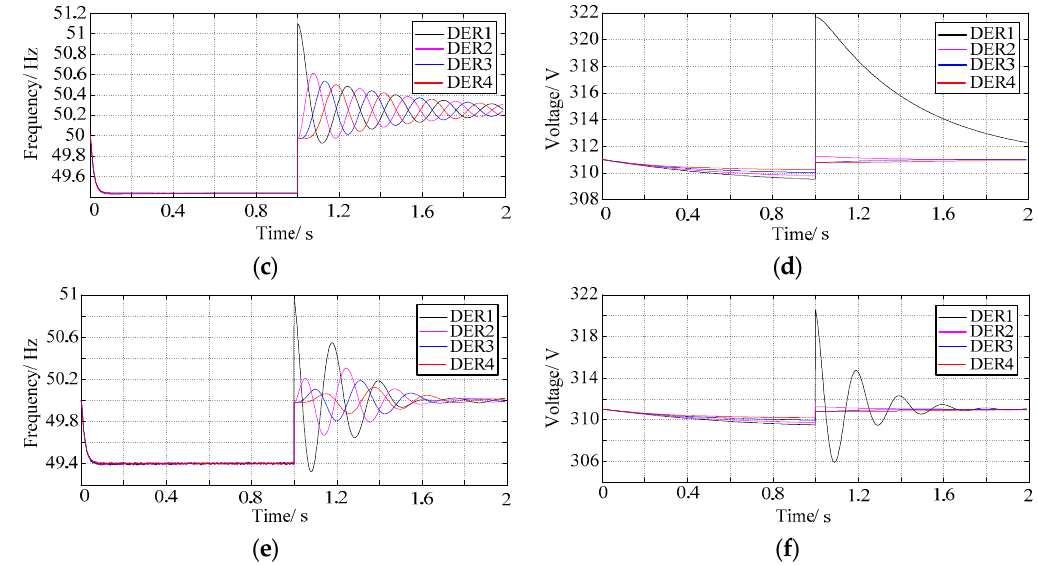
Figure 7. The control effect of the SMC. ( a ) The control effect on the frequency under the situation 1; ( b ) The control effect on the voltage under the situation 1; ( c ) The control effect on the frequency under the situation 2; ( d ) The control effect on the voltage under the situation 2; ( e ) The control effect on the frequency under the situation 3; ( f ) The control effect on the voltage under the situation 3.